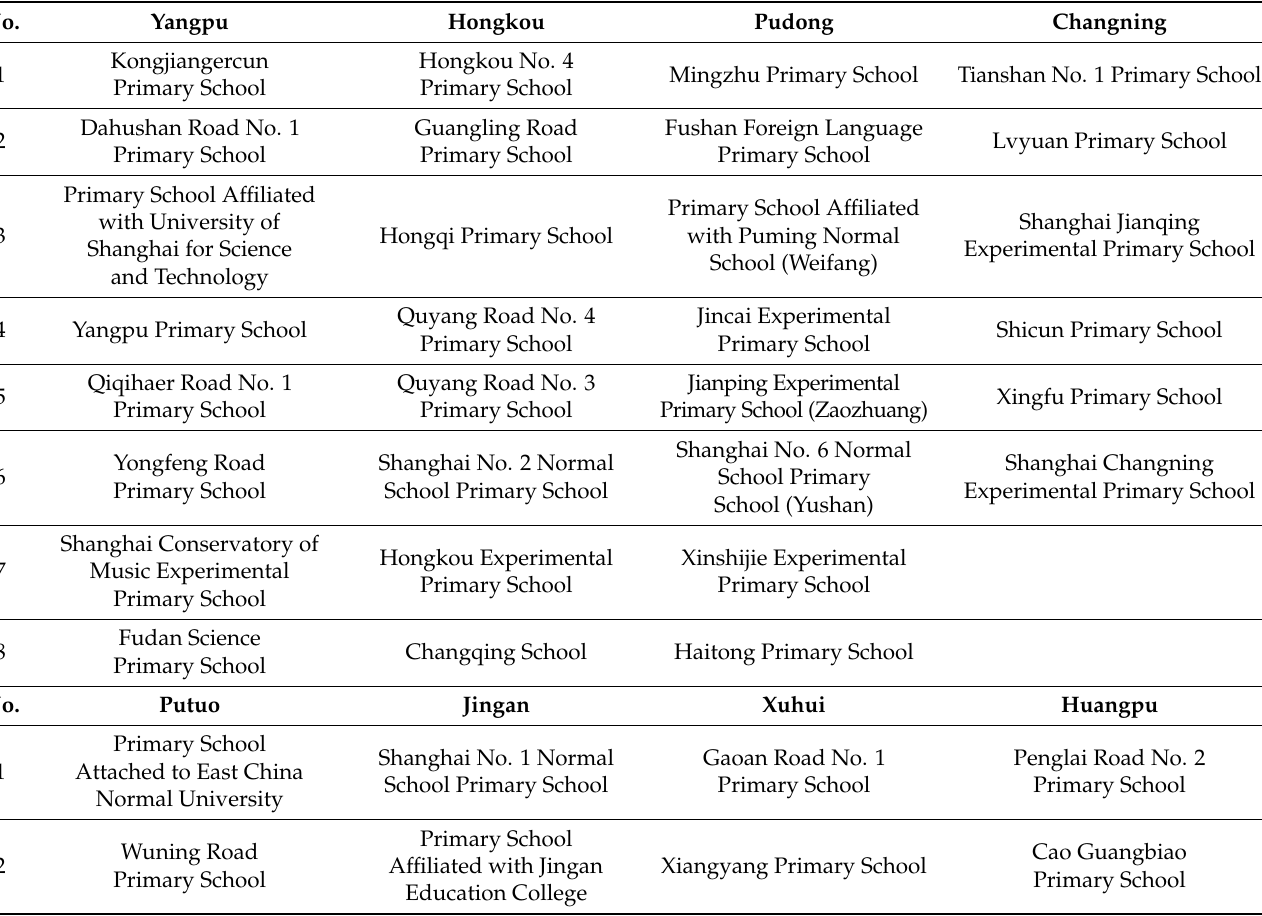
Table A1. Selected key primary schools in each